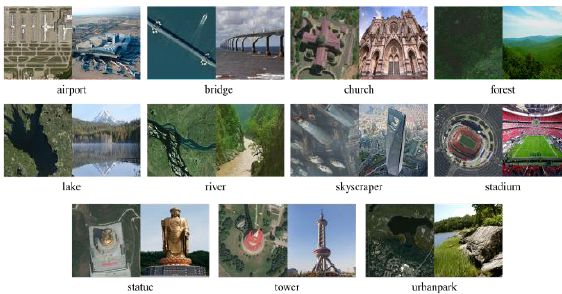
Figure 4. Examples of instances taken from AiRound (The left side of the image pair is aerial image, and the right side is ground street view)